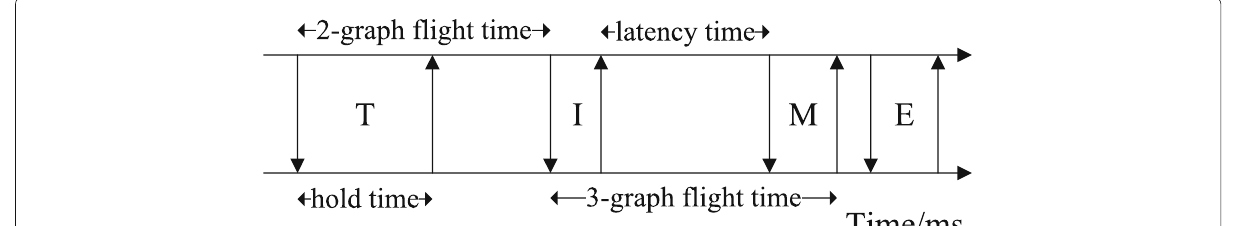
Fig. 1 A keystroke sequence. Each upward and downward pointing arrow indicates a keystroke